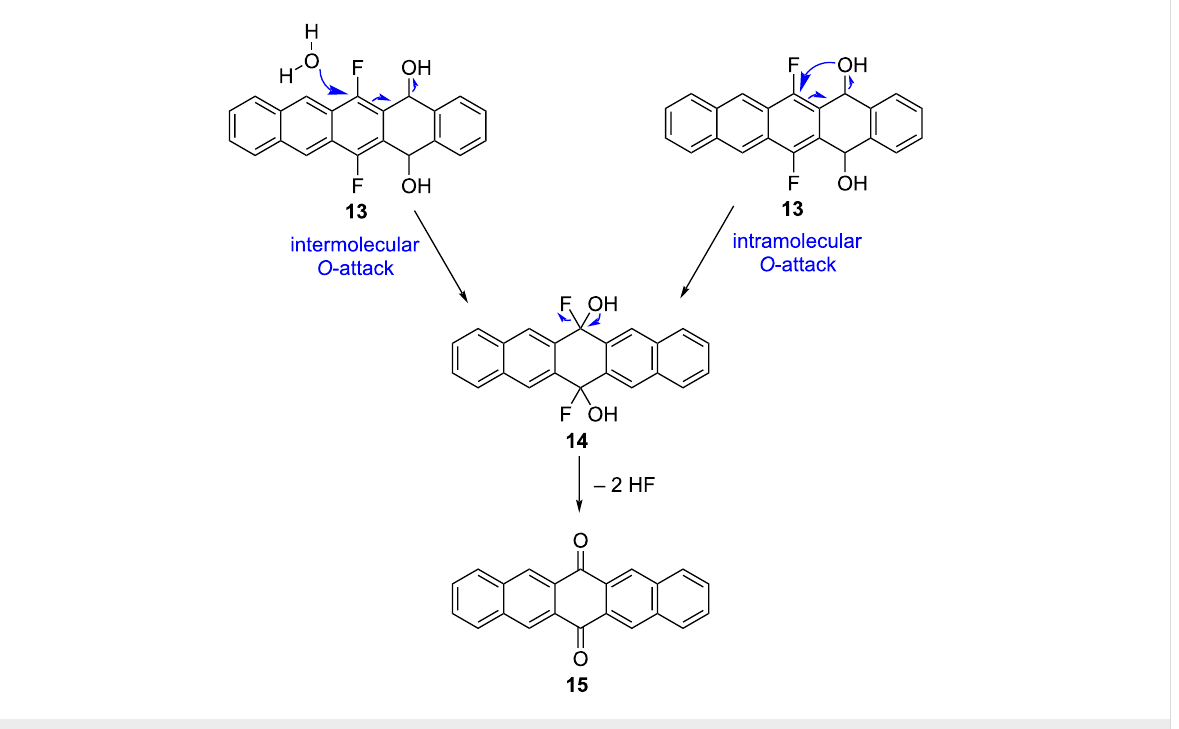
Scheme 3: Decomposition of diol 13 in solution.